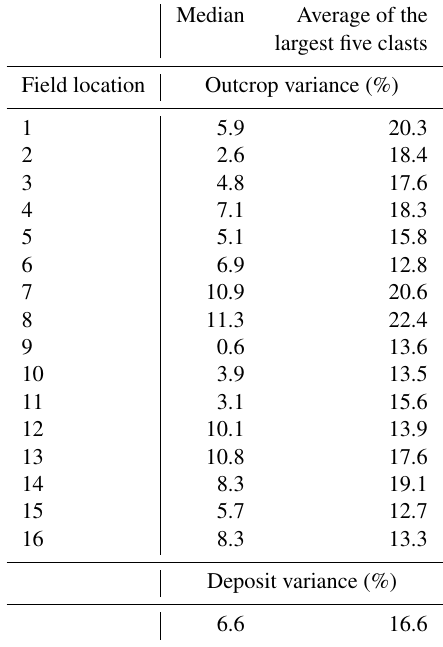
Table A1. Variance across the three areas of 10 to 15 clasts for each outcrop and across the whole deposit for locations from Fig. A2. Deposit variance indicates the average of the outcrop variance. Median Average of the largest five clasts Field location Outcrop variance